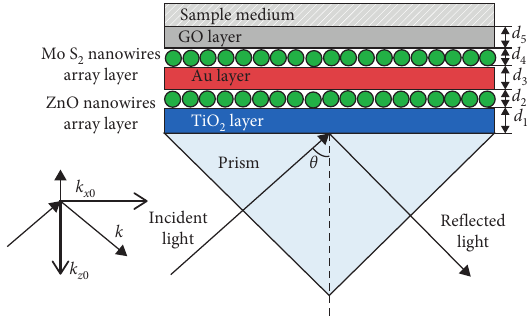
Figure 1: The schematic view of the optical system to excite